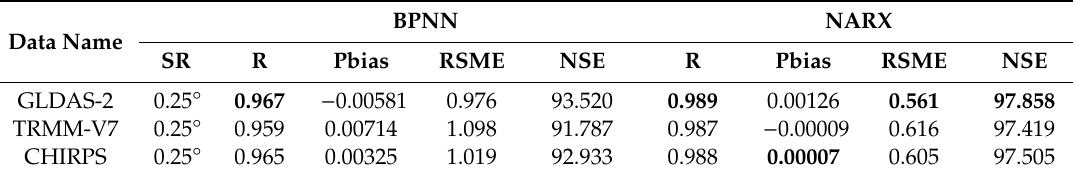
Table 8. Modeling results using different grid precipitation products.